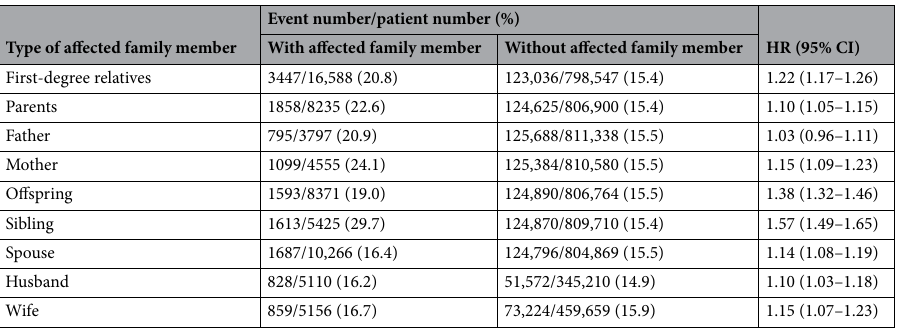
Table 3. Association between familial aggregation of ESRD and risk of incident ESRD. All models were adjusted for age, sex, residential area, income level, and comorbidities such as hypertension, diabetes, ischemic heart disease, cerebrovascular disease, and dyslipidemia. HR hazard ratio, CI confidence interval, ESRD end- stage renal disease.